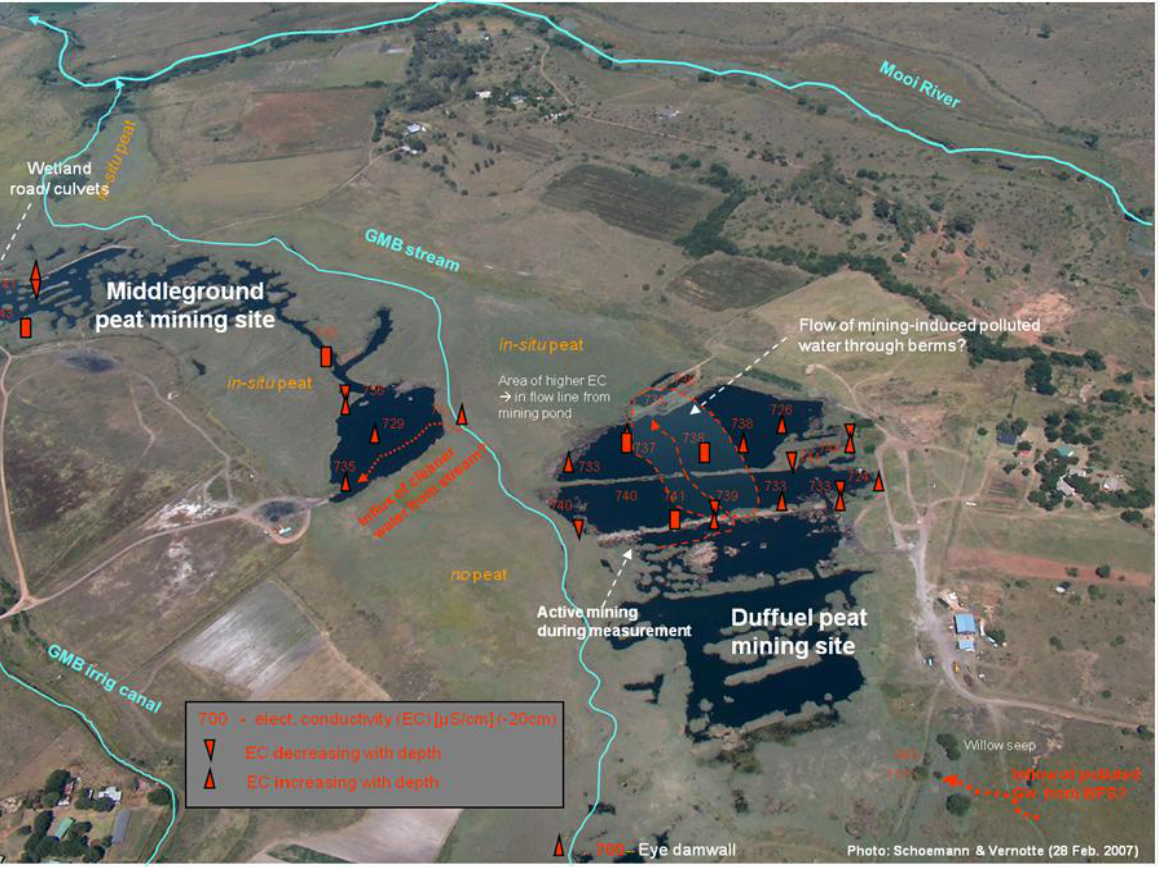
Figure 8. Horizontal and vertical distribution of Electrical Conductivity (EC) values as measured during a survey of the Gerhard Minnebron wetland (measured on 8 June